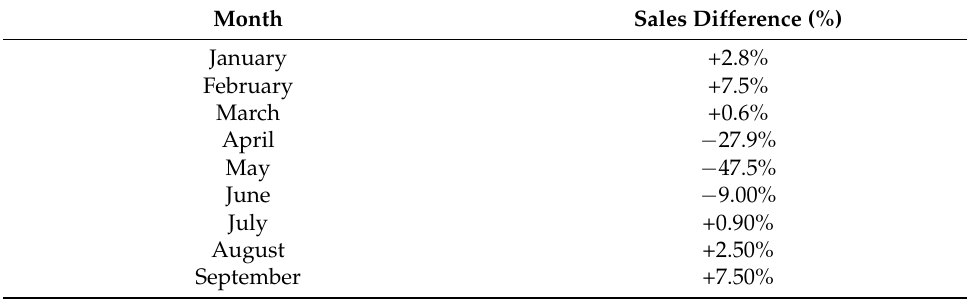
Table 3. Decline in sales between 2020 and 2019 for PDE5 inhibitors.